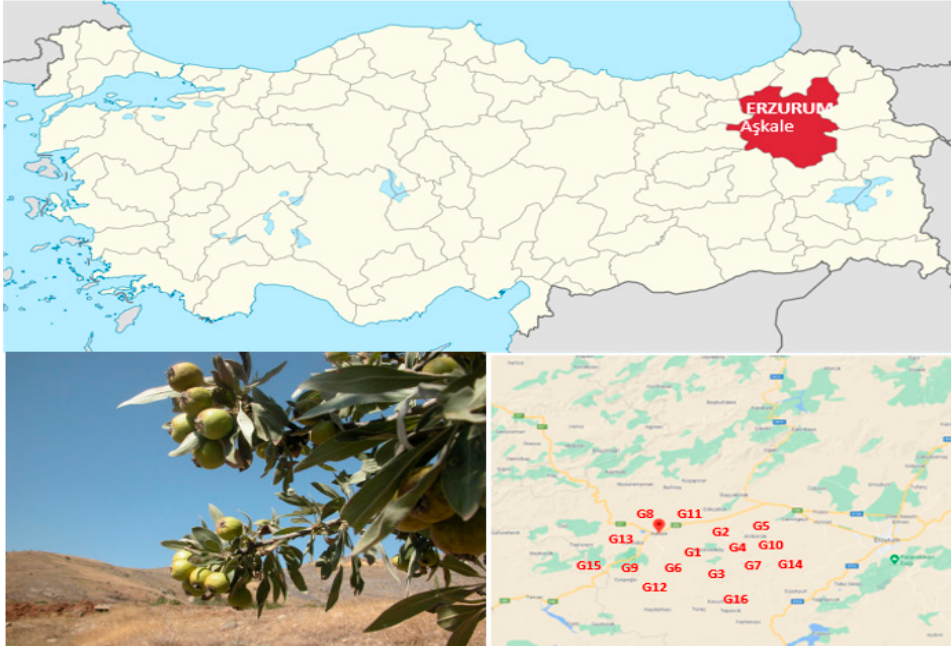
Figure 1. Sampling locations of 16 Pyrus elaeagrifolia Pall. subsp. elaeagrifolia genotypes.